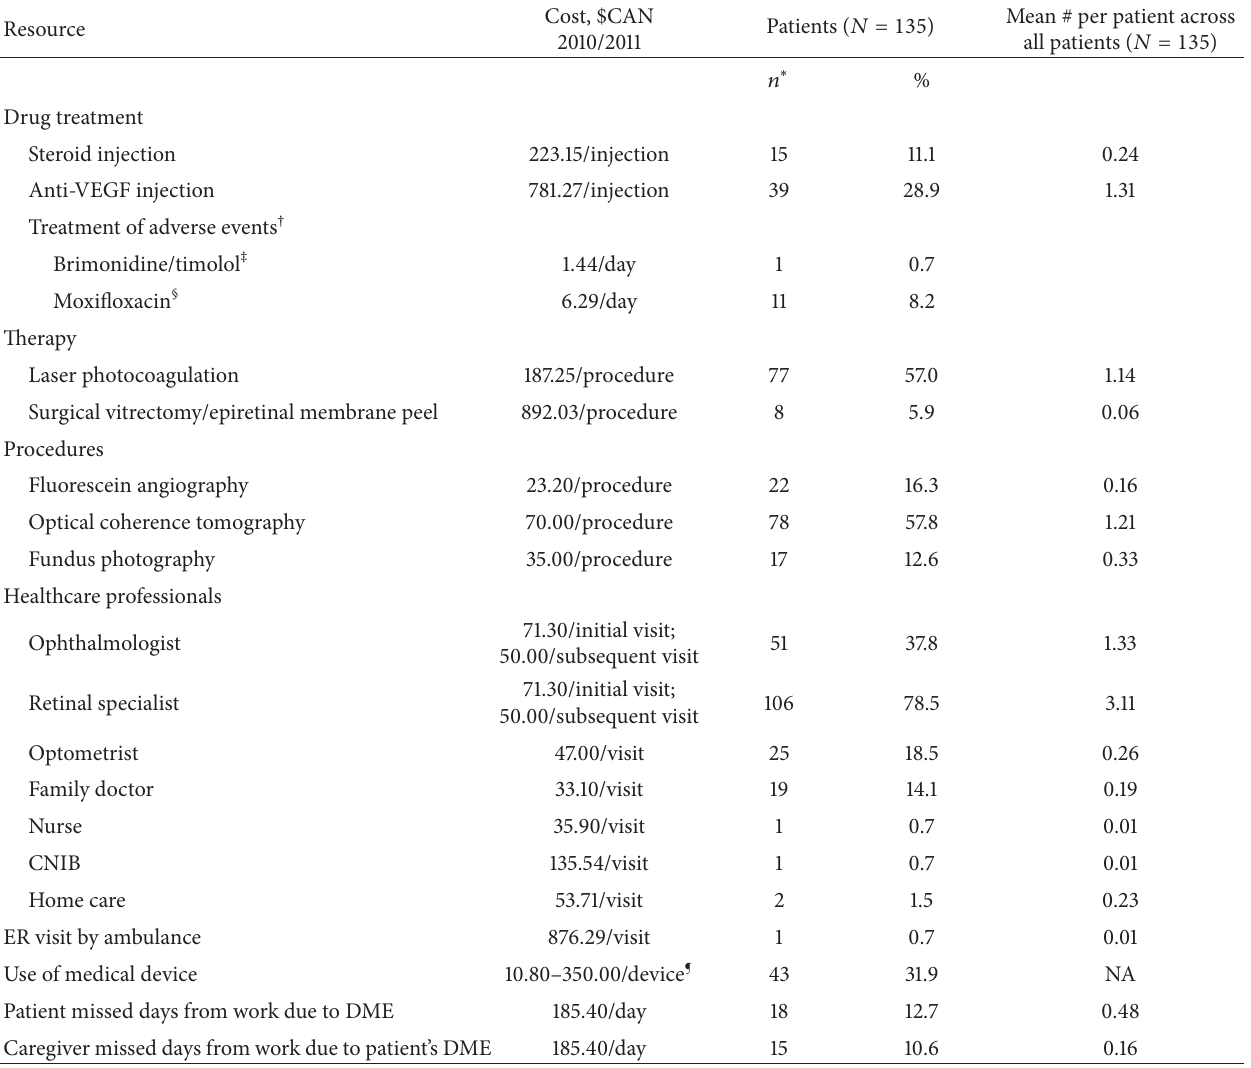
Table 2: DME-related health resource utilization over 6